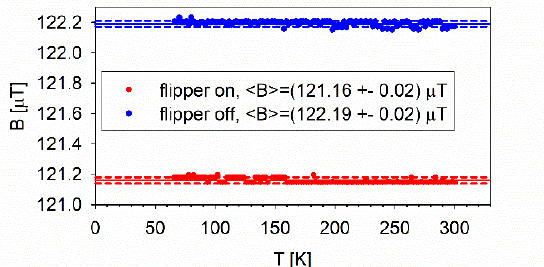
Fig. 3. Magnetic field at the sample position as a function of sample temperature. The field was stable to better than 2·10 -2 µT (or 0.2 mG). Fig. 4. Filled black symbols from neutron backscattering